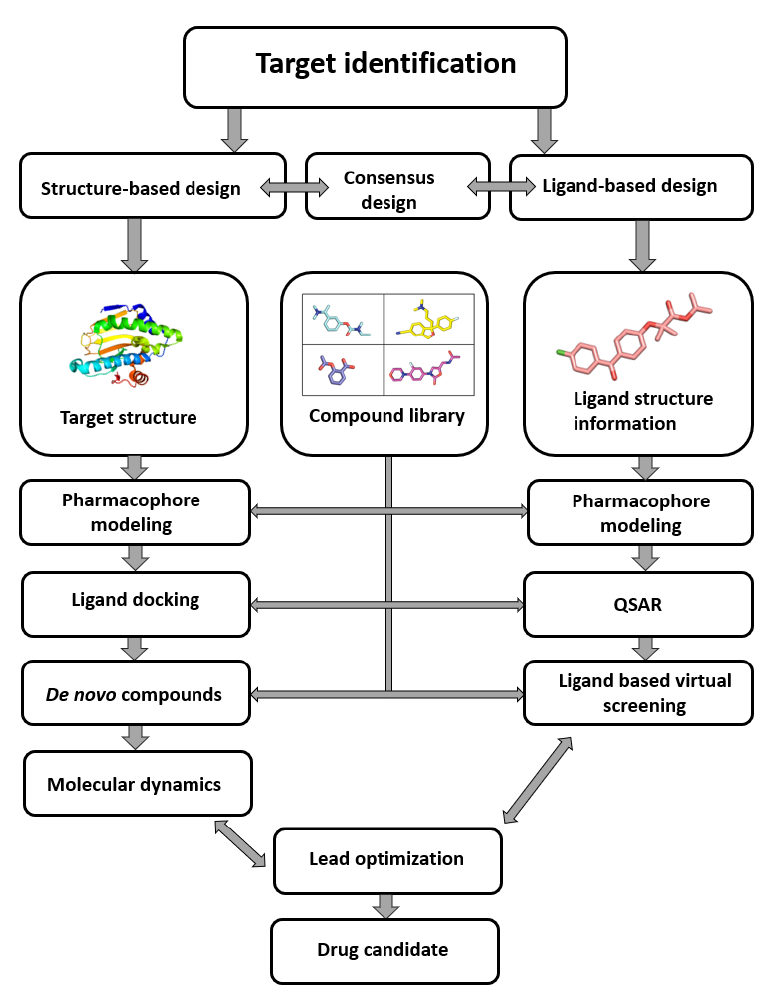
Figure 1. Computer-aided drug design process chart used to obtain lead compounds (based on Sliwoski et al. [5]).